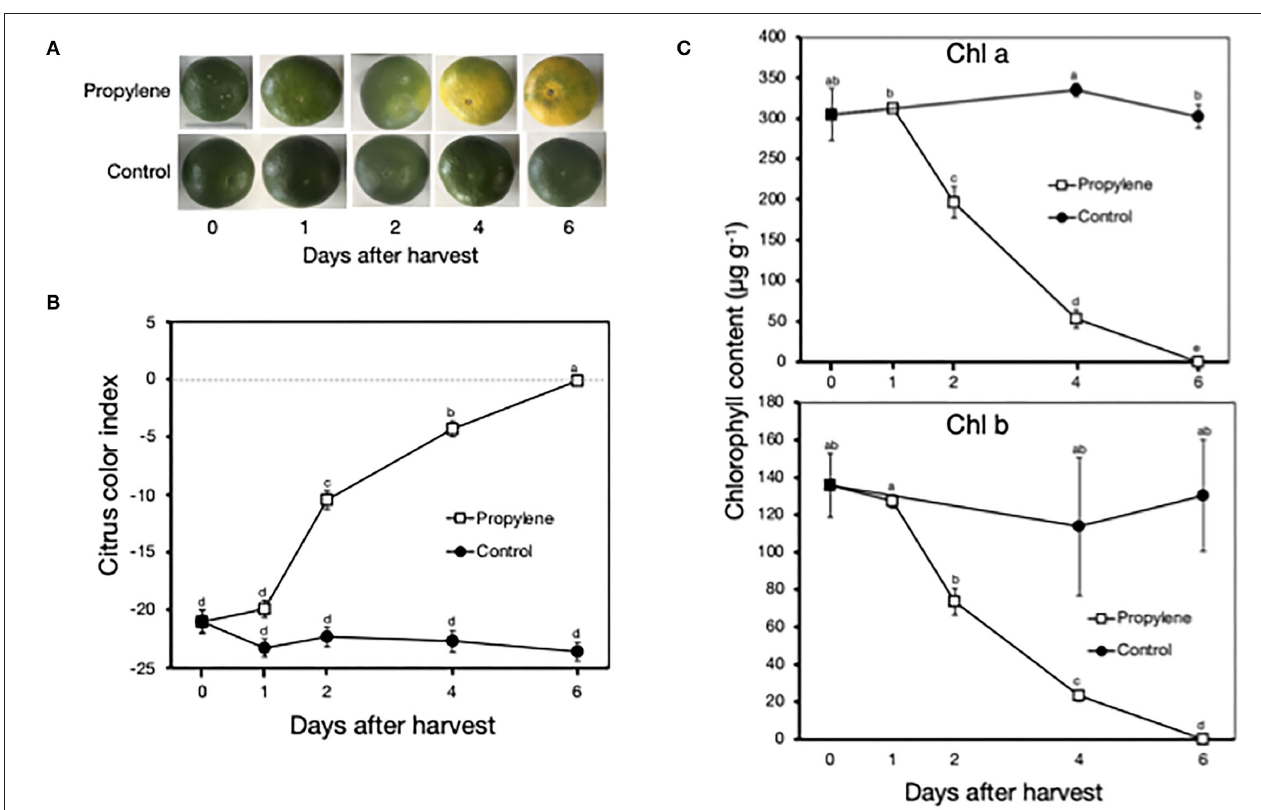
FIGURE 1 | Characterization of ethylene-induced peel degreening in postharvest Satsuma mandarin fruit. (A) Appearance of fruit during continuous treatment with propylene, an analog of ethylene. (B) Changes in citrus color index. Dashed line indicates color index 0, which represents a color change from green to yellow/orange. (C) Changes in peel chlorophyll content. Propylene treatment was carried out continuously at 25 ◦ C to induce ethylene signaling. Each data point represents the mean ( ± SE) of six replicate fruit. Different letters indicate significant differences in ANOVA (Tukey’s test, P <